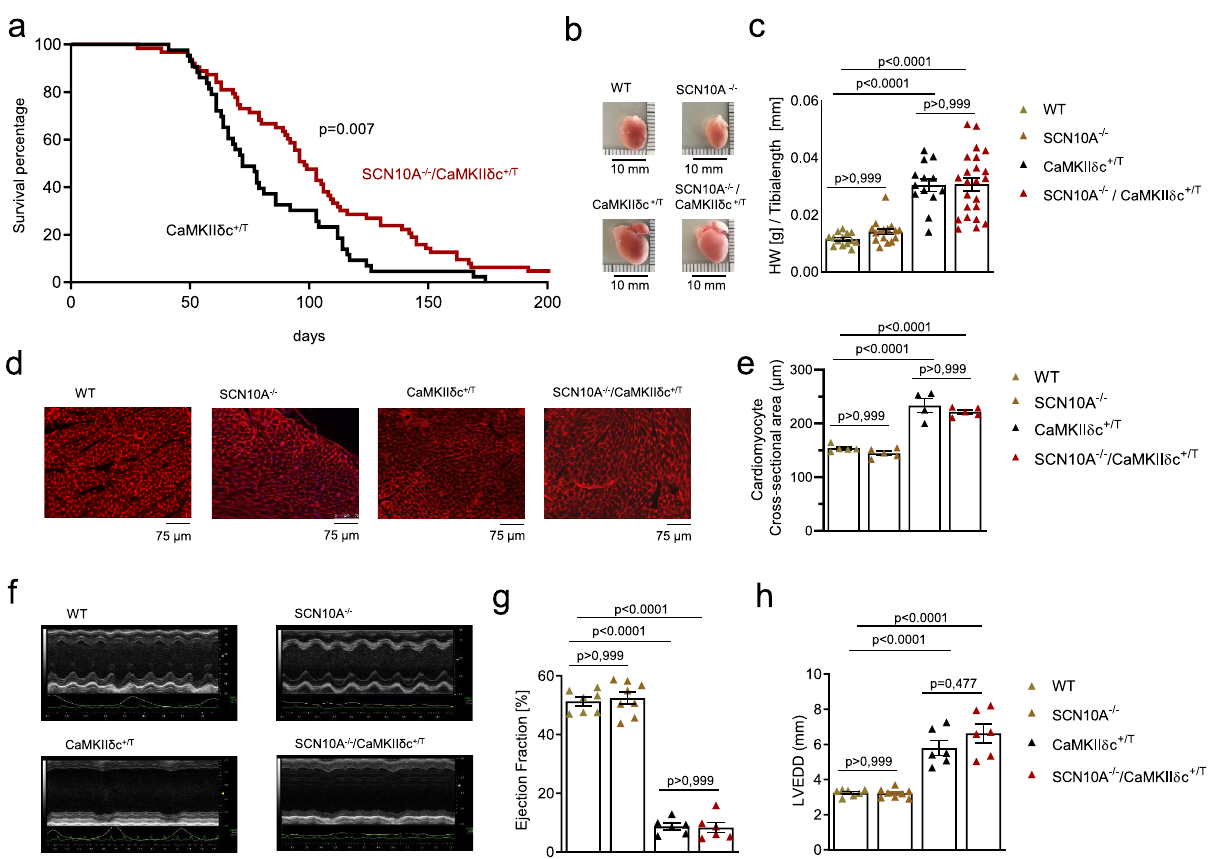
Fig. 4 Knockout of the S cn10a (Na V 1.8) gene in CaMKII δ c + /T mice improves survival. a Survival curve of CaMKII δ c + /T and SCN10A − / − /CaMKII δ c + /T (43 vs. 64 animals, median survival 72 vs. 98 days, blinded analysis). Log-rank (Mantel – Cox test and Gehan – Breslow – Wilcoxon test (two-tailed analysis) were performed to calculate the survival percentage of mice. Probability vs CaMKII δ c + /T . b Hearts from WT, SCN10A − / − , CaMKII δ c + /T , and SCN10A − / − /CaMKII δ c + /T mice. c Ratio of heart weight to tibia length as a parameter of cardiac hypertrophy. CaMKII δ c + /T and SCN10A − / − /CaMKII δ c + /T showed a signi fi cant increase in this ratio compared to WT and SCN10A − / − mice. Data were analyzed by one-way ANOVA with post hoc Bonferroni ’ s correction. ( N = hearts studied, WT = 14, SCN10A − / − = 16, CaMKII δ c + /T = 13, and SCN10A − / − /CaMKII δ c + /T = 23). Data were presented as mean